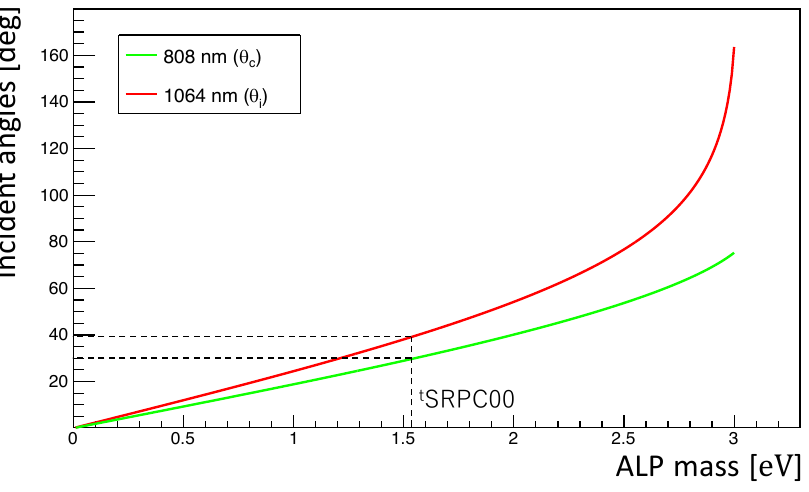
Figure 11. Expected incident angles of creation and inducing lasers, θ c and θ i , respectively, as a function of ALP mass when two wavelengths of creation (808 nm) and inducing lasers (1064 nm) are assumed, resulting in the fixed wavelength of FWM signals, 651 nm, in